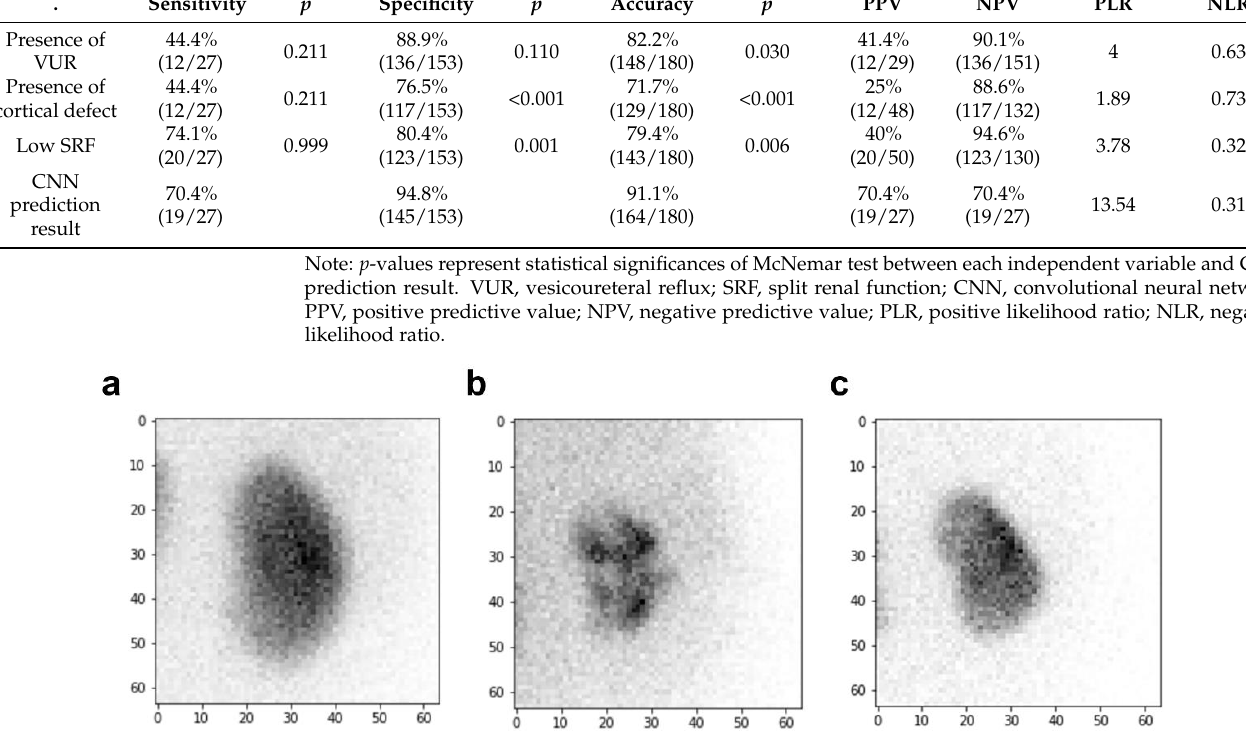
mality in 99m Tc-DMSA renal scan and without recurrent UTI. It was classified as a case without UTI by CNN prediction. ( b ) A case with multiple cortical defects in 99m Tc-DMSA renal scan and with